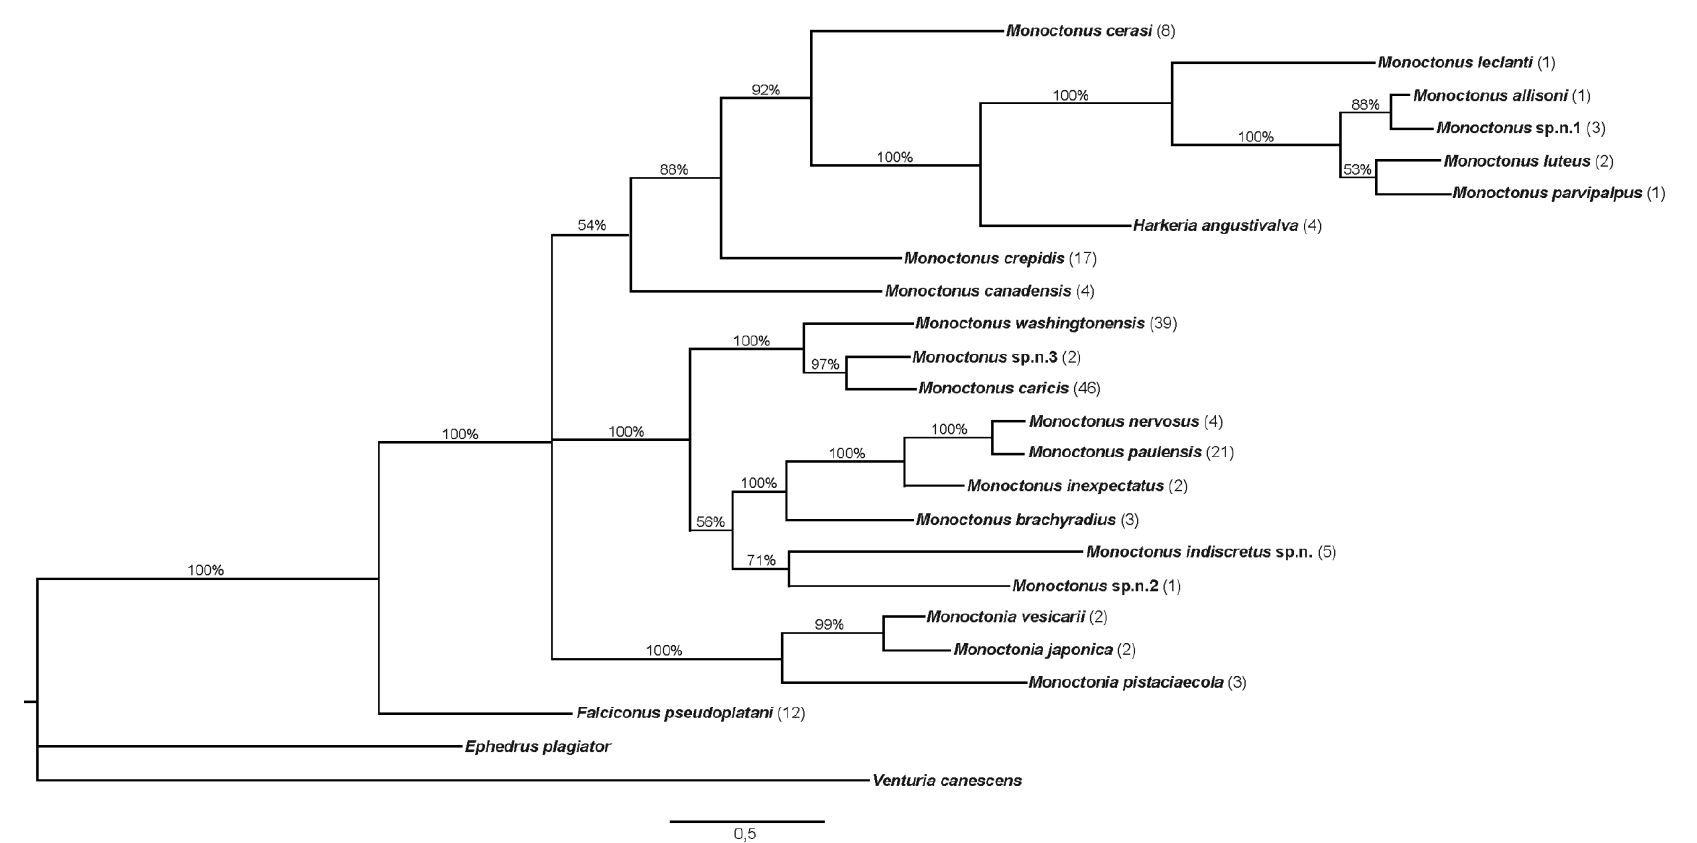
Figure 4. Phylogenetic tree constructed based on sequences of COI . The number of specimens of each species is shown in parentheses. Bayesian posterior probabilities are shown above branches.